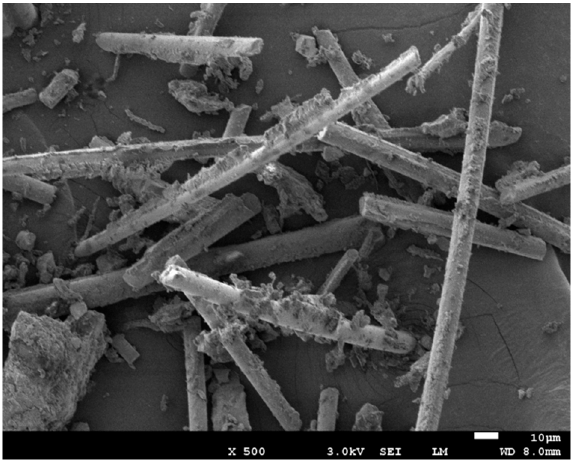
Figure 1. SEM images of N-WPCBs.